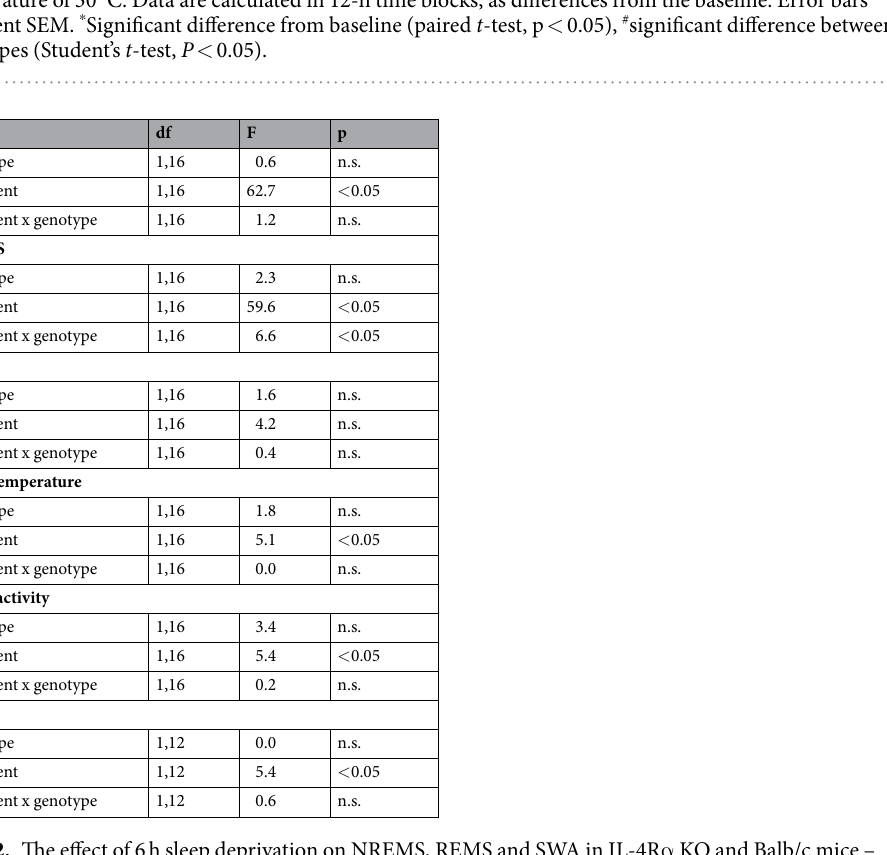
Table 2. The effect of 6 h sleep deprivation on NREMS, REMS and SWA in IL-4R α KO and Balb/c mice – statistical